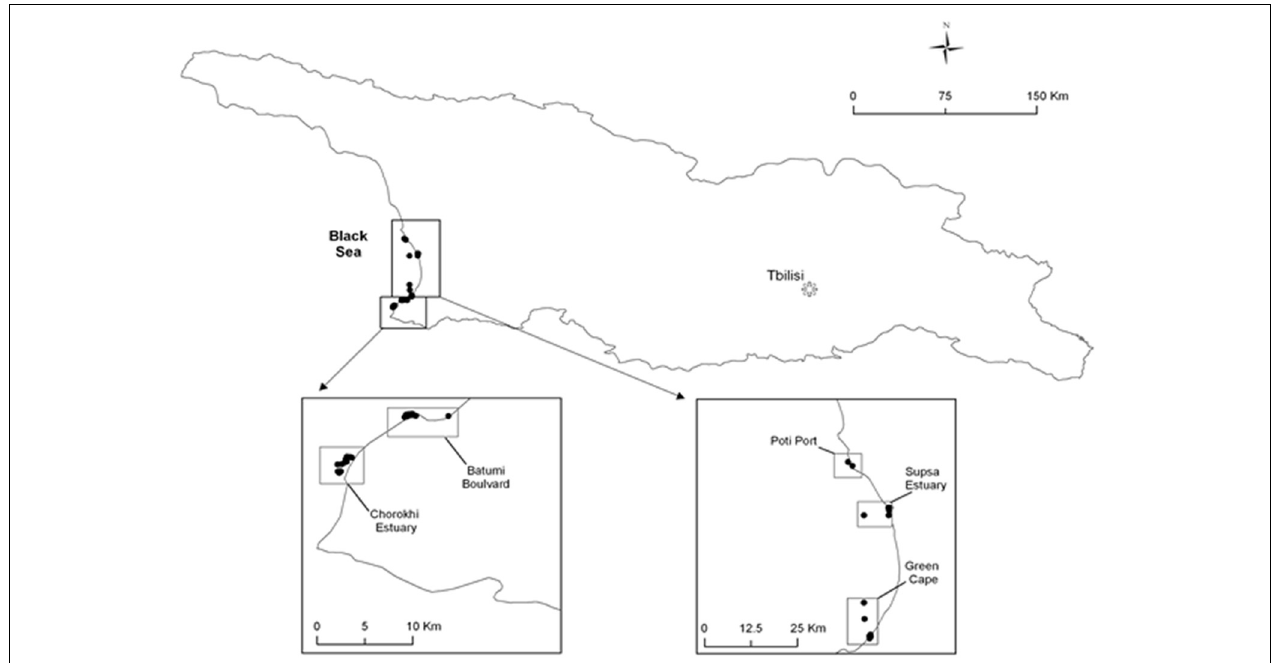
FIGURE 1 | Map showing locations of sampling sites along Black